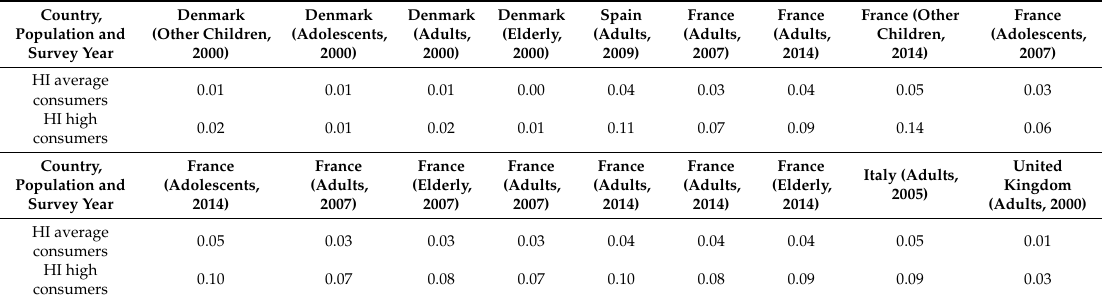
Table 6. Hazard indices for chronic dietary exposure to heavy metals from blue